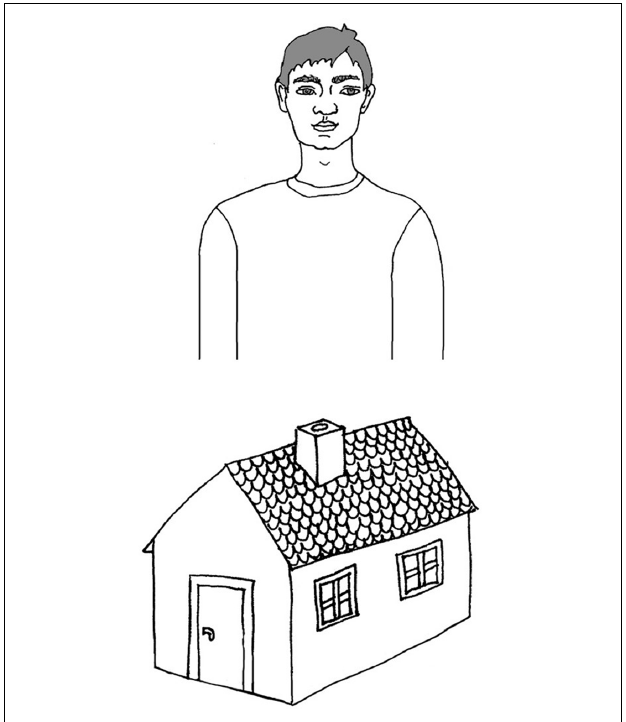
FIGURE 2 | The response card used in VOT